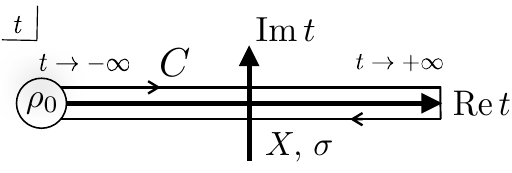
Figure 1 . The closed-time-path on which the generating functional is de(cid:12)ned. When we assume that the initial density operator ^ (cid:26) 0 is given by a thermal density operator: ^ (cid:26) 0 another path to the negative imaginary time (See appendix